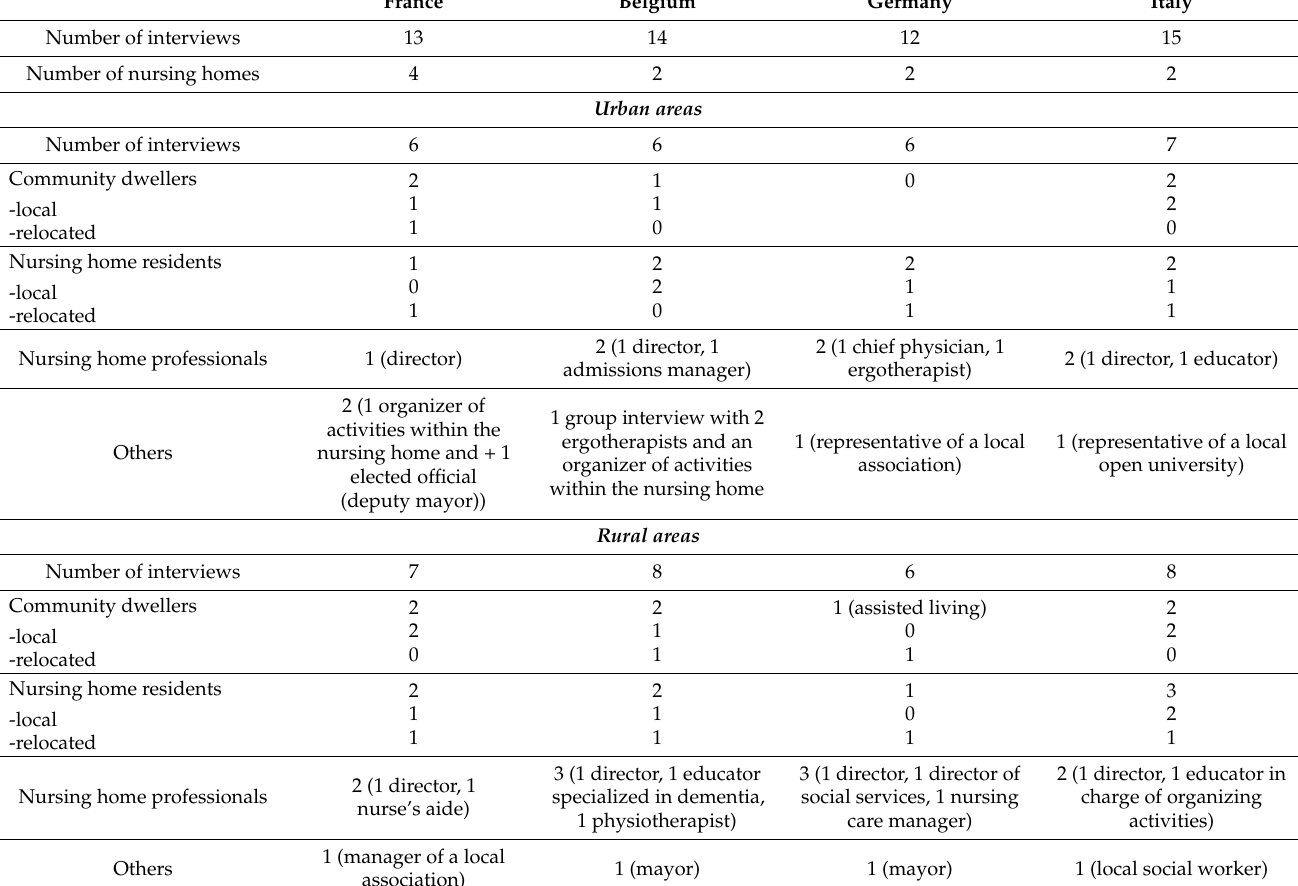
Table 1. Details of the number of interviews and types of